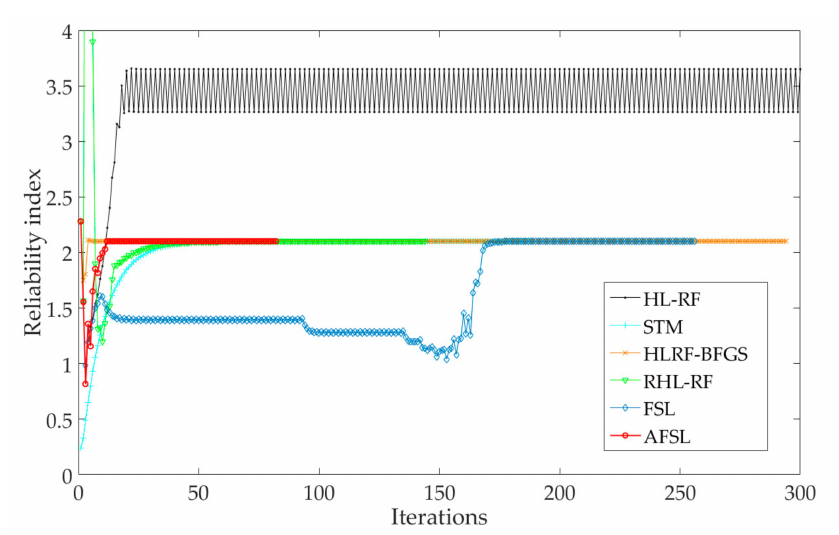
Figure 10. Iterative processes of reliability index for Example 5.